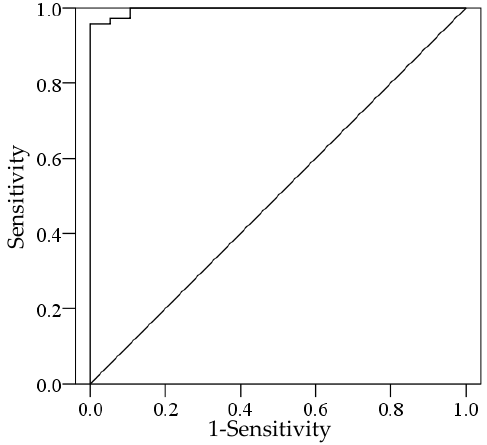
Figure 9. ROC curve of the occurrence probability prediction model of smoldering during sub-surface fires.